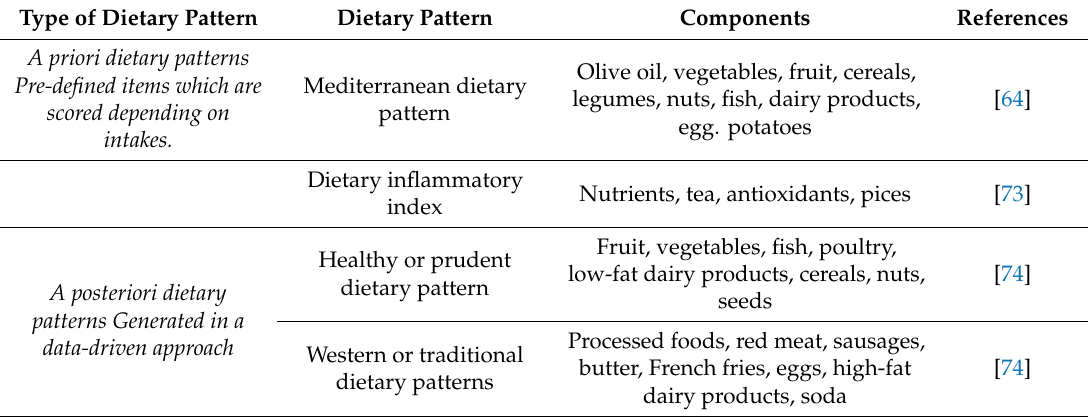
Table 2. Brief description of the dietary patterns discussed in the current